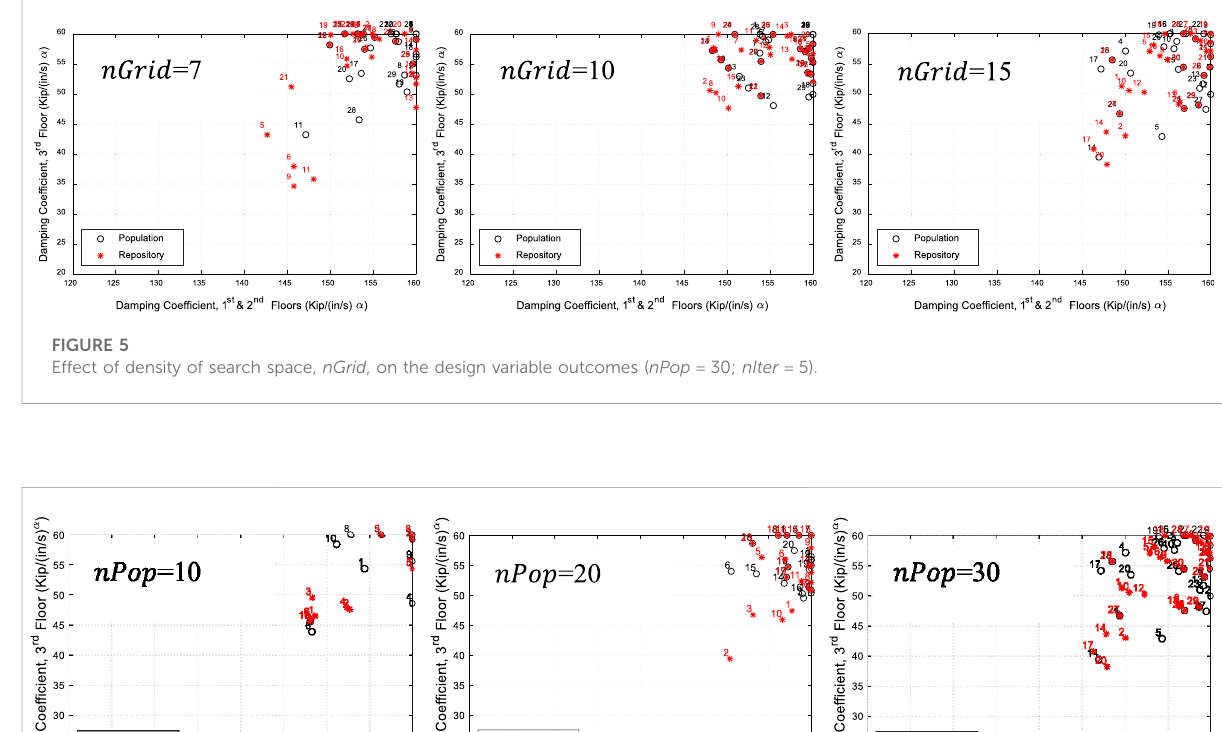
FIGURE 6 Effect of the number of particles in population, nPop , on the design variable outcomes ( nGrid (cid:2) 15; nIter (cid:2) 5).